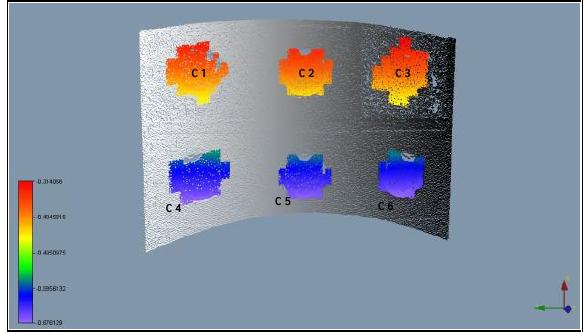
Figure 6. 3D reconstruction of analysis result for the lower center